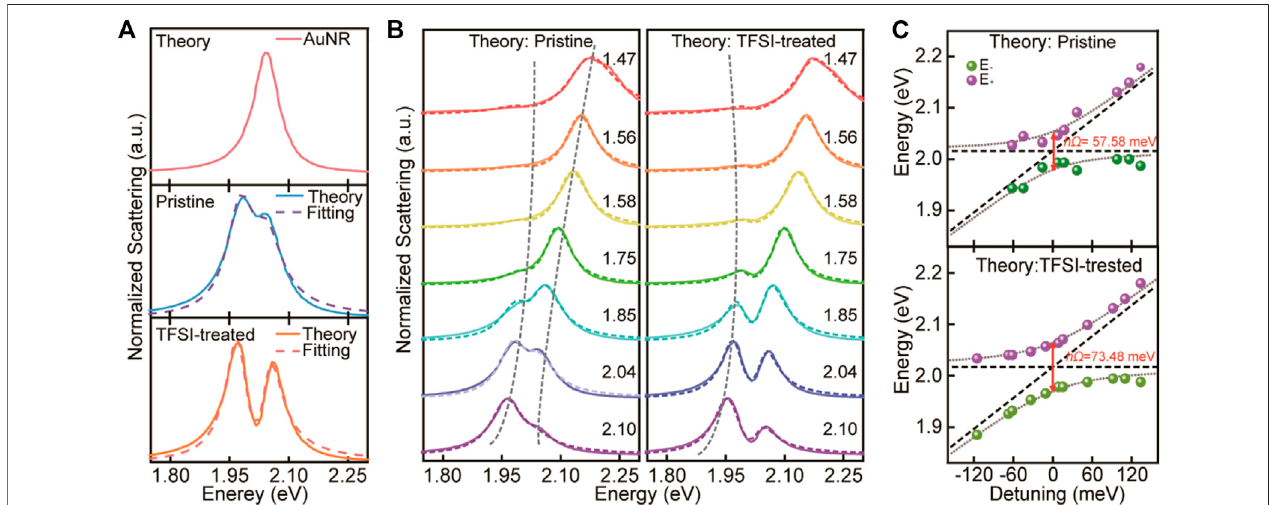
FIGURE 4 | Numerical simulations and COM analyses of the resonance coupling. (A) FDTD simulated scattering spectra of an individual gold nanorod (upper panel), an individual pristine heterostructure (middle panel), and individual TFSI-treated heterostructure (lower panel). Dashed lines are fi tting curves using COM model. (B) Simulated scattering spectra from different individual heterostructures. Left: pristine heterostructures. Right: heterostructures upon chemical treatment. Numbers next tothe curves indicate theaspect ratios ofthegoldnanorods intheheterostructures.Dashed linesareCOM fi ttingcurves. (C) Scattering peaks extracted from the COM model as a function of the detuning energy between the LPM and exciton transition energy. Upper: pristine heterostructures. Lower: heterostructures upon chemical treatment. The horizontal and diagonal black dashed lines indicate the exciton transition energy and LPM energy, respectively. The colored symbols are extracted from the COM fi tting spectra shown in (B) . The dotted curves are guide for the eyes.